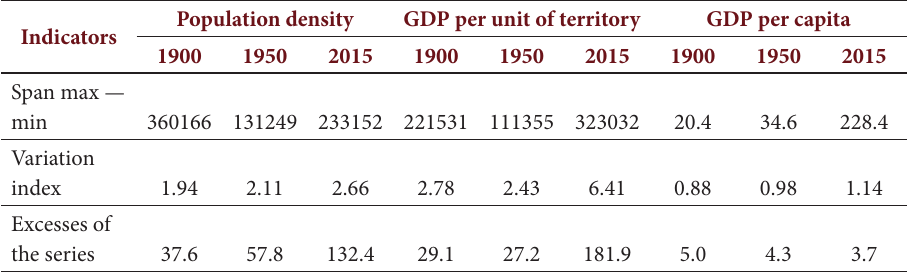
Table 1. Some signs of variation in population density, GDP/PPP per unit of territory and per capita, for 200 permanent countries of the